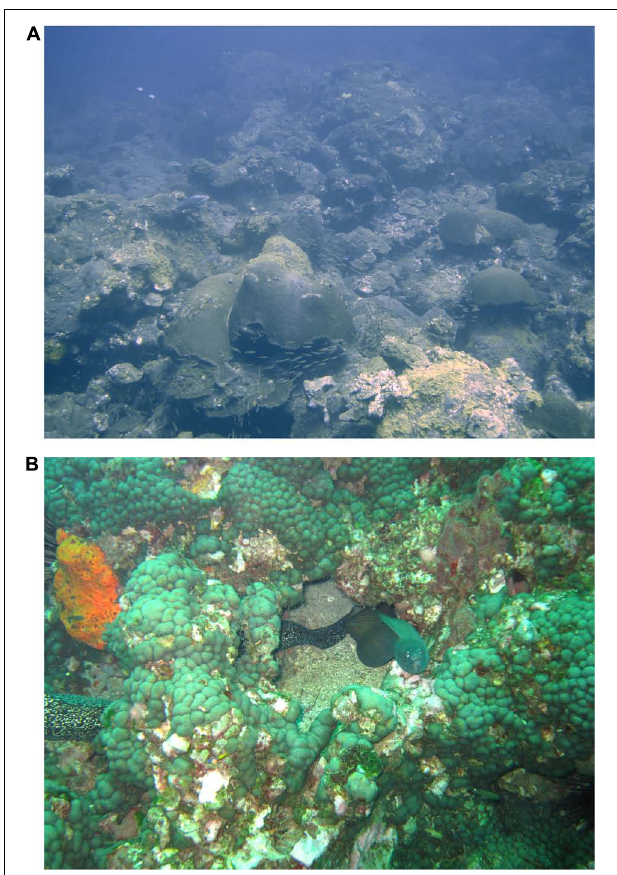
FIGURE 3 | Coral reefs and coral communities in the Flower Garden Banks National Marine Sanctuary. (A) East Flower Garden (–18 m), and (B) Stetson Bank (–20 m). Photos by